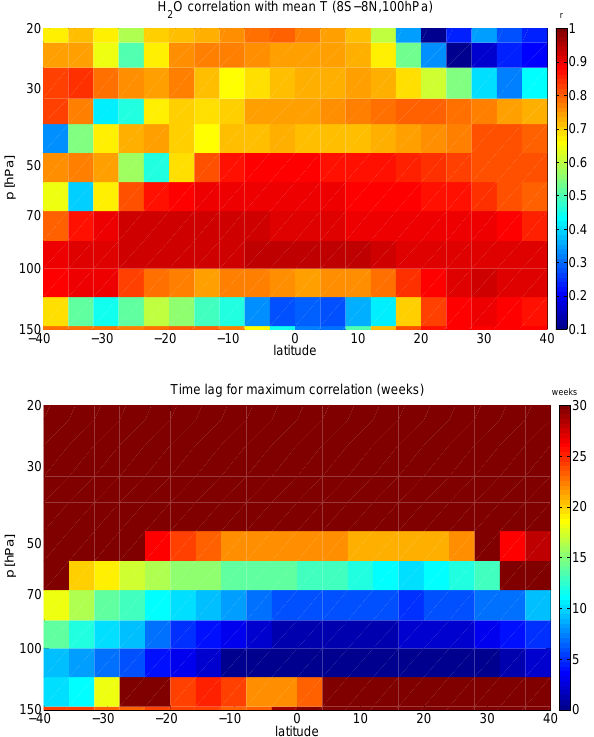
Fig. 1. Maximum correlation of MLS tropical zonal mean 100hPa temperatures (8 ◦ S–8 ◦ N) and MLS zonal mean water vapor at each latitude and pressure level on top. Maximum correlation is found by shifting the water vapor time series by a certain time lag (in weeks) displayed in the bottom plot. The correlation is high ( r > 0 . 7) throughout the lower stratosphere from Equator to midlatitudes. Upward and poleward transport can be identified by the increas- ing time lag in regions where r is still high. Poleward transport is faster than upward and also faster in the Northern